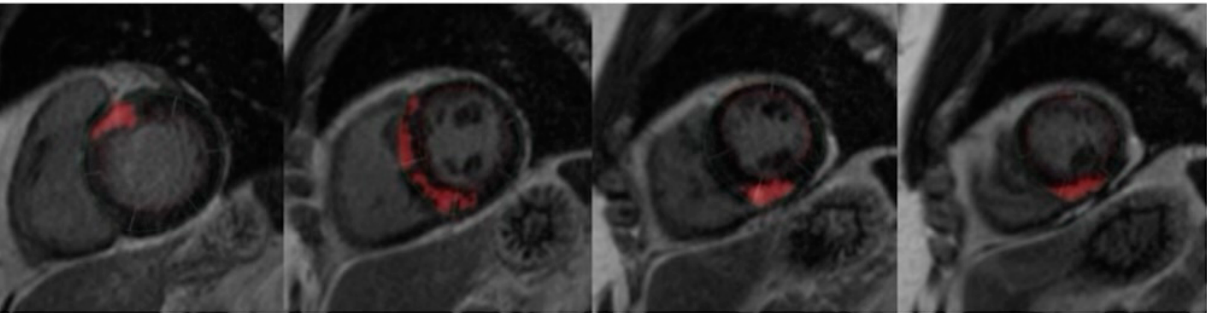
Figure 3. CMR calculation of late gadolinium enhancement of the left ventricle using 6-SD threshold.